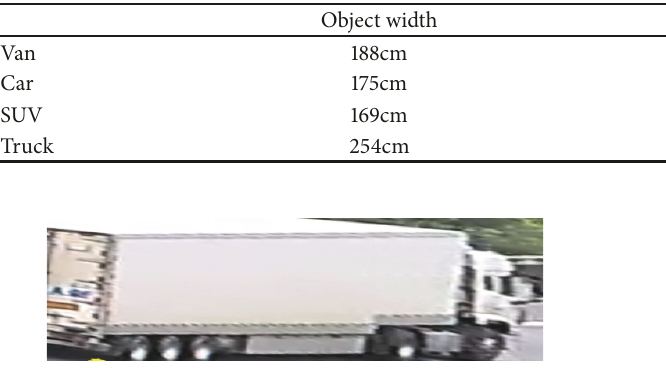
Table 1: Test results for white vehicle size.